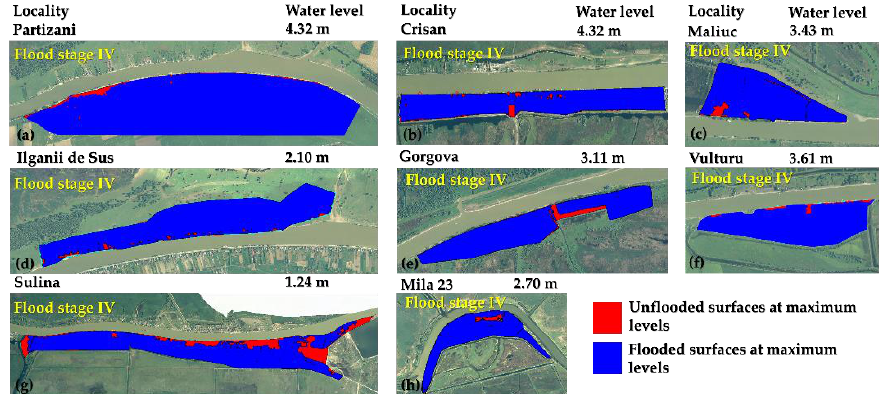
Figure 14. The representation of digital maps with flooded areas for settlements: ( a )—Partizani, ( b )—Crișan, ( c )—Maliuc, ( d )—Ilganii de sus, ( e )—Gorgova, ( f )—Vulturu, ( g )—Sulina, ( h )—Mila 23, by using GIS analysis, at high resolution DTM 0.5 m × 0.5 m, static method.